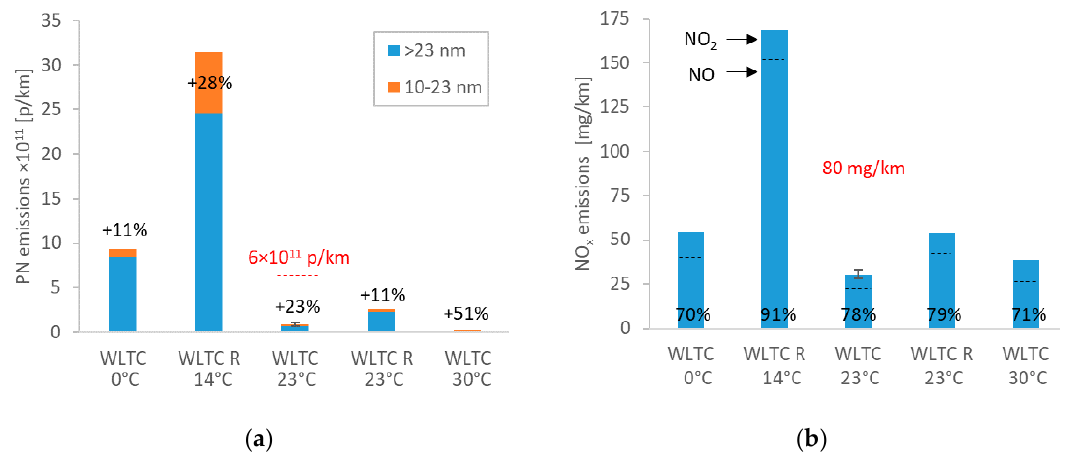
Figure 2. Emissions during laboratory test over the Worldwide Light-duty Test Cycle (WLTC) at different ambient temperatures: ( a ) Particle Number (PN) >23 nm and 10–23 nm. Percentages give the ratio 10–23 nm to >23 nm PN concentrations; ( b ) Bag NO x . Percentage gives the ratio NO/NO x based on the FTIR (Fourier Transform Infrared Spectrometer). Error bars show min-max values of 2 repetitions. The red dotted line gives the laboratory emission limits, when applicable. R = Regenerating.